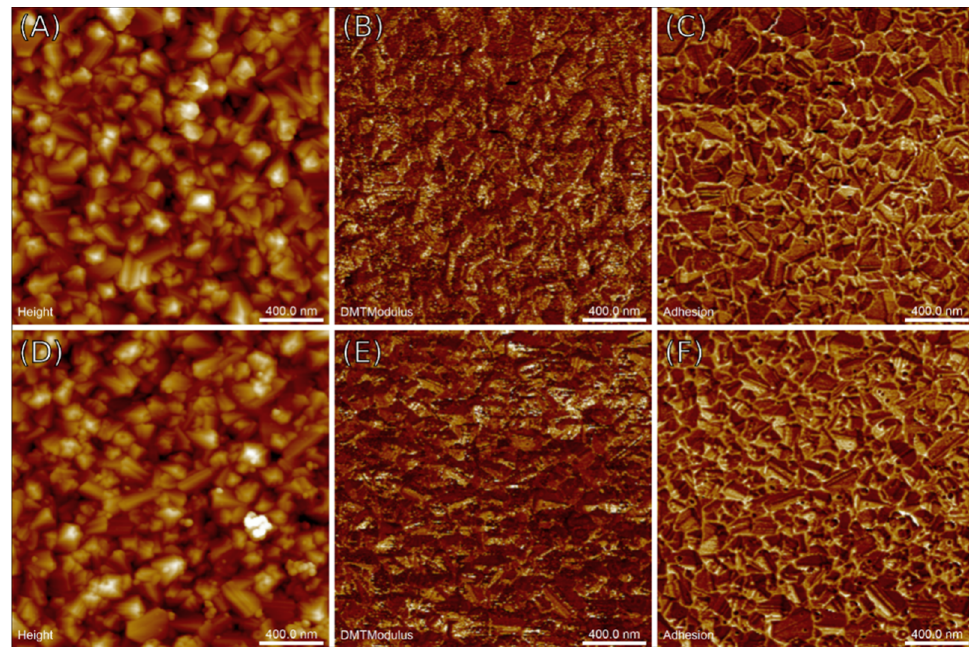
Figure 2. AFM images of the BDD films with different boron doping levels: ( A – C ) 2000 ppm and ( D – F ) 7000 ppm made in PF-QNM mode and subsequently separated into data channels revealing various aspects of the surface inhomogeneities: ( A ) and ( D ) surface topography (height), ( B ) and ( E ) Young’s pseudo-modulus (DMT modulus), and ( C ) and ( F ) tip-surface adhesion force (adhesion). Table 1. Surface texture and mechanical characteristics derived from AFM images: S gr —planar grain concentration, S q —surface roughness (RMS), ISAD—image surface area difference, S tr —texture an- isotropy ratio, D AC —mean grain size from the autocorrelation function, D Otsu —grain size estimated